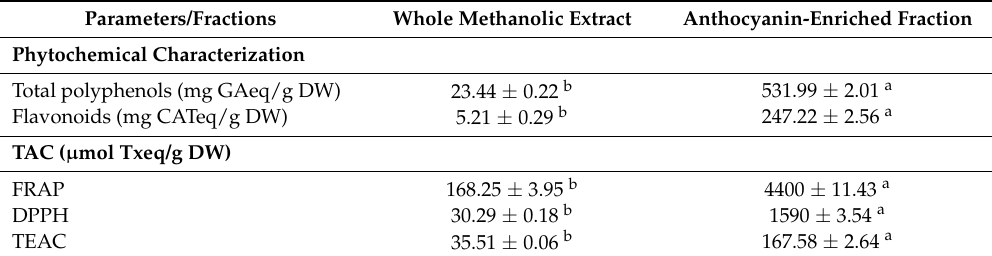
Table 1. Phytochemical characterization and antioxidant capacity of the